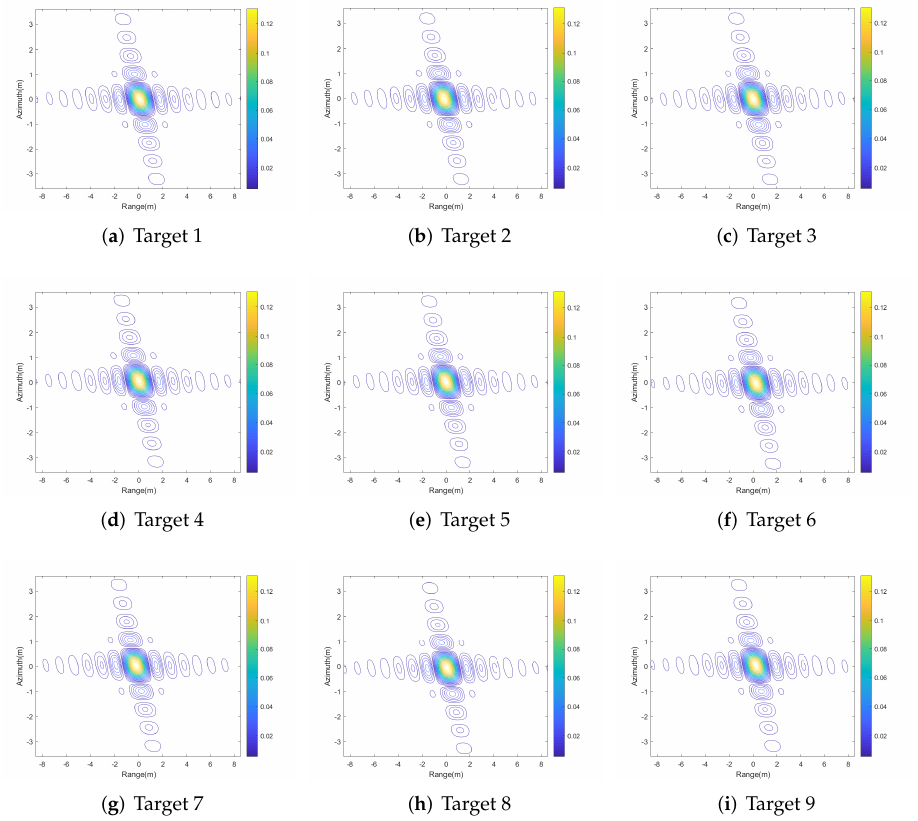
Figure 7. Imaging results of the nine point targets by the proposed method based on BiCoT-ESRM. The measured metrics of the imaging results of the proposed method and RMOSE are given in Tables 2 and 3, respectively. The theoretical values of peak sidelobe ratio (PSLR) and integrated sidelobe ratio (ISLR) are − 13.26 dB and − 10.4 dB, respectively. The 3 dB impulse response width (IRW) is 0.68 m in the azimuth direction and 1.01 m in the range direction, which are calculated based on the system parameters and bistatic